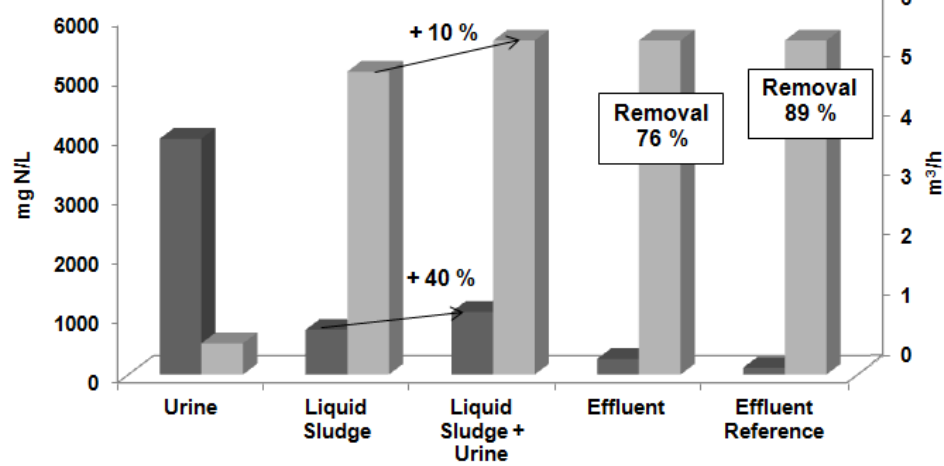
Figure 4. Total nitrogen concentration (  ) in mg N/L and volumetric flow (  ) in (m 3 /h) in the urine, liquid sludge, liquid sludge after the urine addition, effluent in the experiment I, and effluent for the removal efficiency reference (89%)